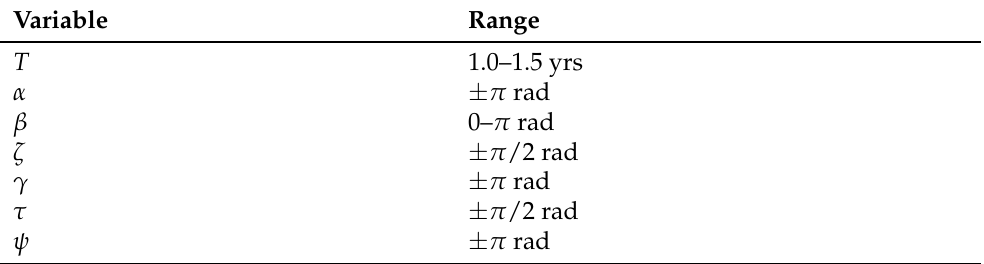
Table 1. Range of mission